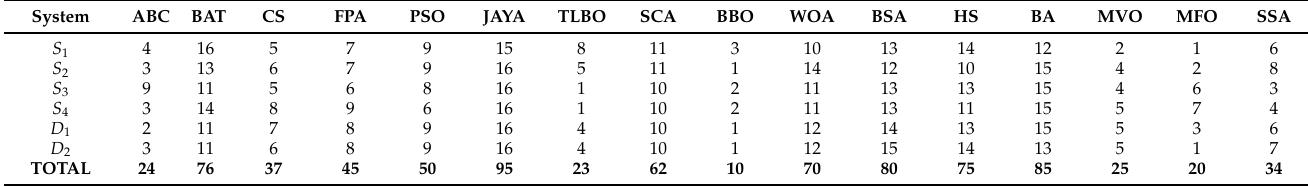
Table 12. Success ranking according to the best results of the metaheuristic algorithms for the training process.